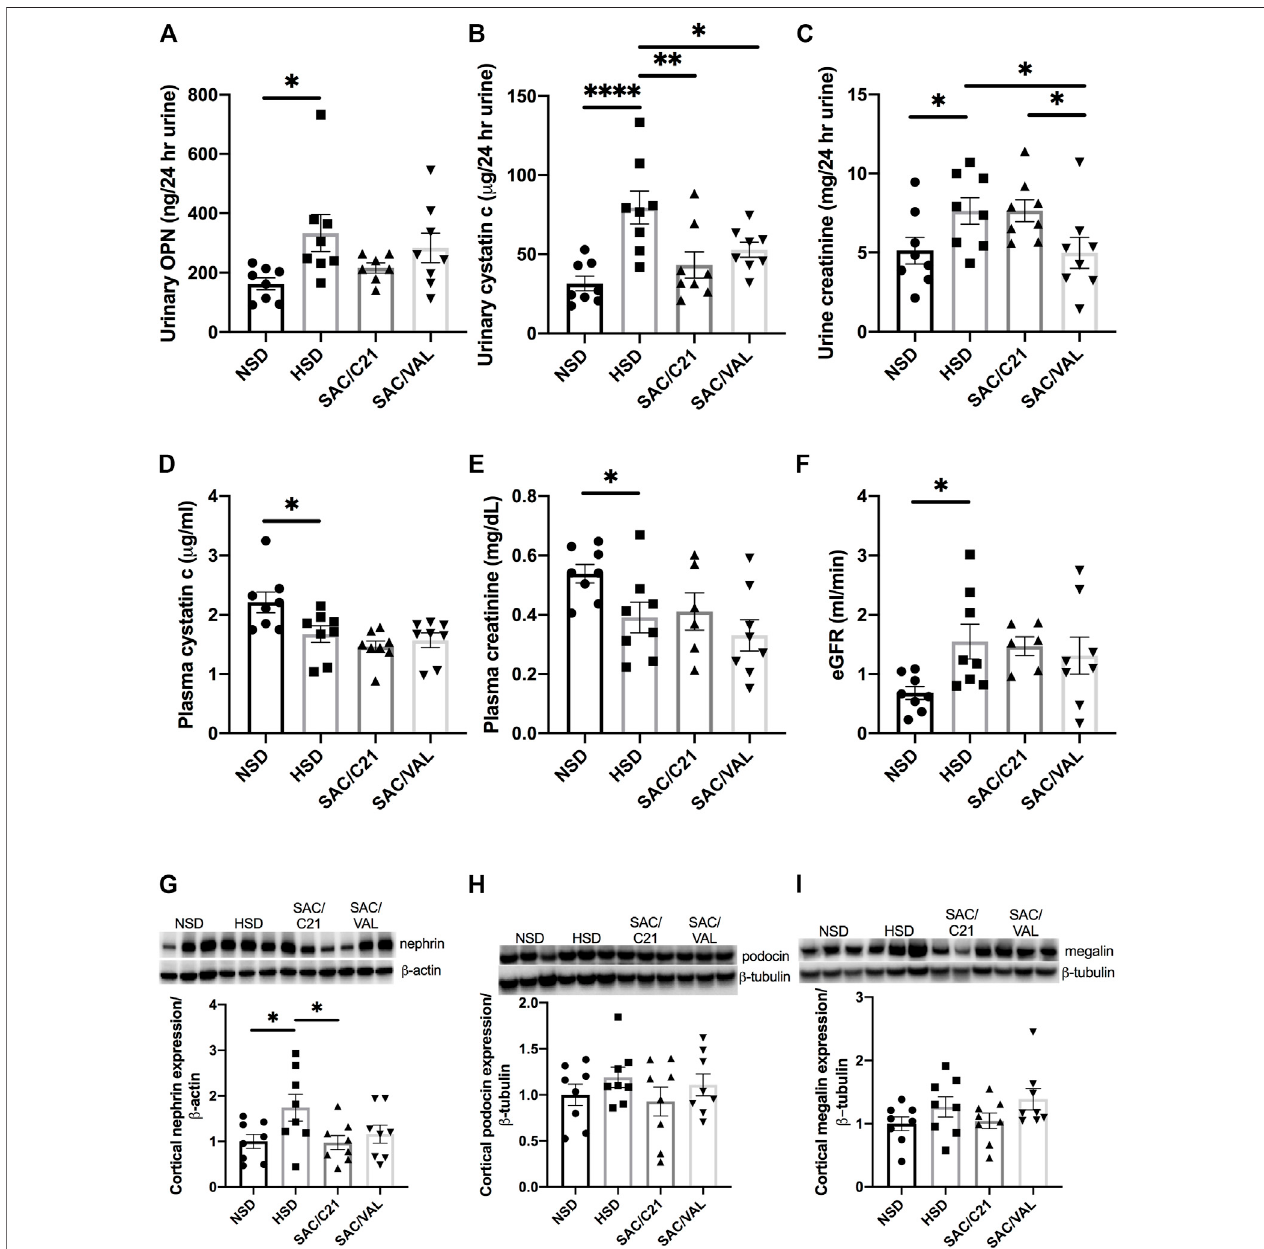
FIGURE2| Analysisofrenalinjuryviamarkersandindicatorsofglomerularandtubulardamage (A) urinaryosteopontinnormalizedto24 hurinevolume, (B) urinary cystatin C normalized to 24 h urine volume, (C) urinary creatinine, (D) plasma cystatin C, (E) plasma creatinine, (F) eGFR, (G) nephrin expression in kidney cortex, (H) podocin expression in kidney cortex, and (I) megalin expression in kidney cortex from obese Zucker rats on NSD or HSD and treated with vehicle, SAC/C21, or SAC/ VAL. Data shown as mean ± SEM, analyzed by one-way ANOVA, followed by Fisher ’ s LSD test. Results are considered signi fi cant at * p < 0.05, ** p < 0.01, **** p < 0.0001 with a 95% con fi dence interval; n (cid:1) 6 – 8 for urinary osteopontin, plasma creatinine, and eGFR and n (cid:1) 8 for urinary and plasma cystatin C, urinary creatinine, nephrin, podocin, and megalin expression. NSD — normal salt diet fed + vehicle treated obese control, HSD — high salt diet fed + vehicle treated obese control,